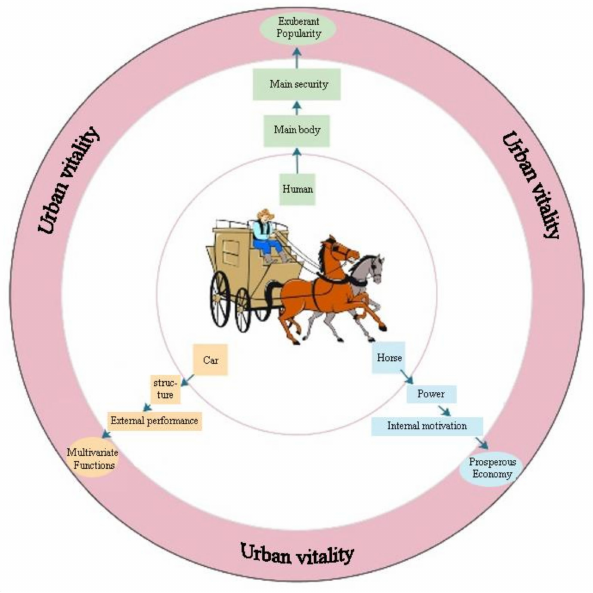
Figure 1. Mapping scheme of urban